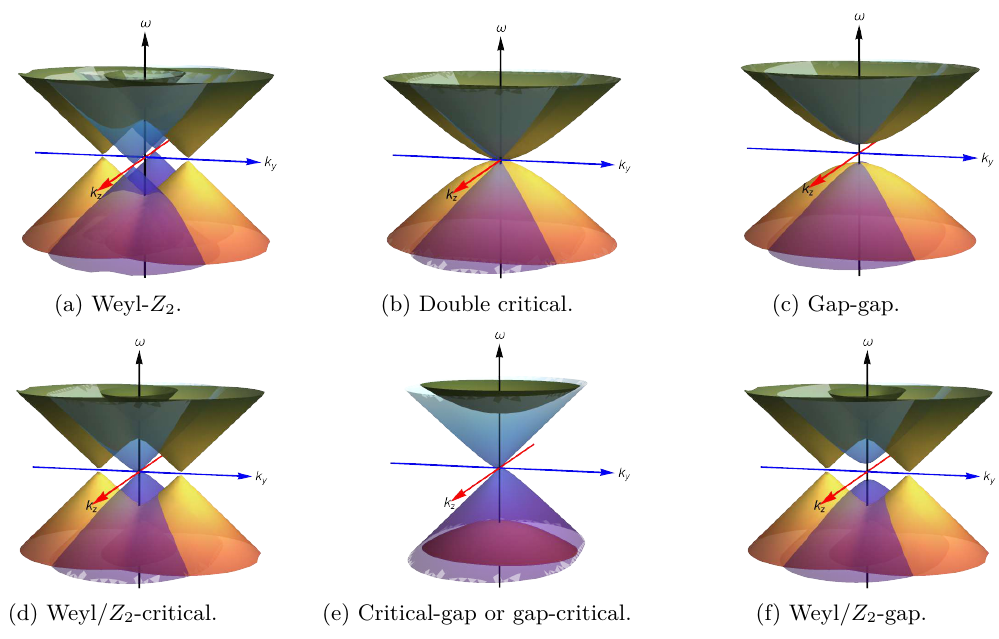
Figure 3. The energy spectrum (2.6) as a function of k y and k z with k x = 0 . From (a) to (f): the system has two pairs of Weyl/ Z 2 nodes (a), two critical Dirac nodes (b), fully gapped (c), one pair of Weyl/ Z 2 nodes and a critical Dirac node (d), a critical Dirac node and a gapped phase (e) and the case of one pair of Weyl/ Z 2 nodes with two gapped bands